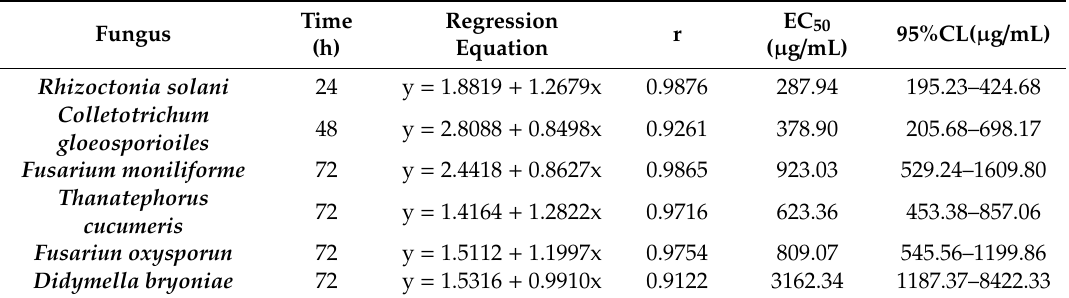
Table 4. The antifungal activities of the essential oil of T. flousiana (EC 50